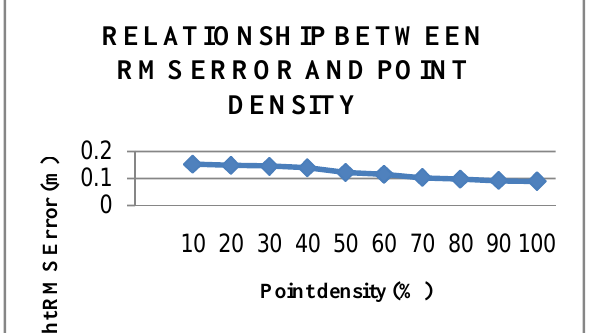
Figure 6: Relationship between RMS Error and